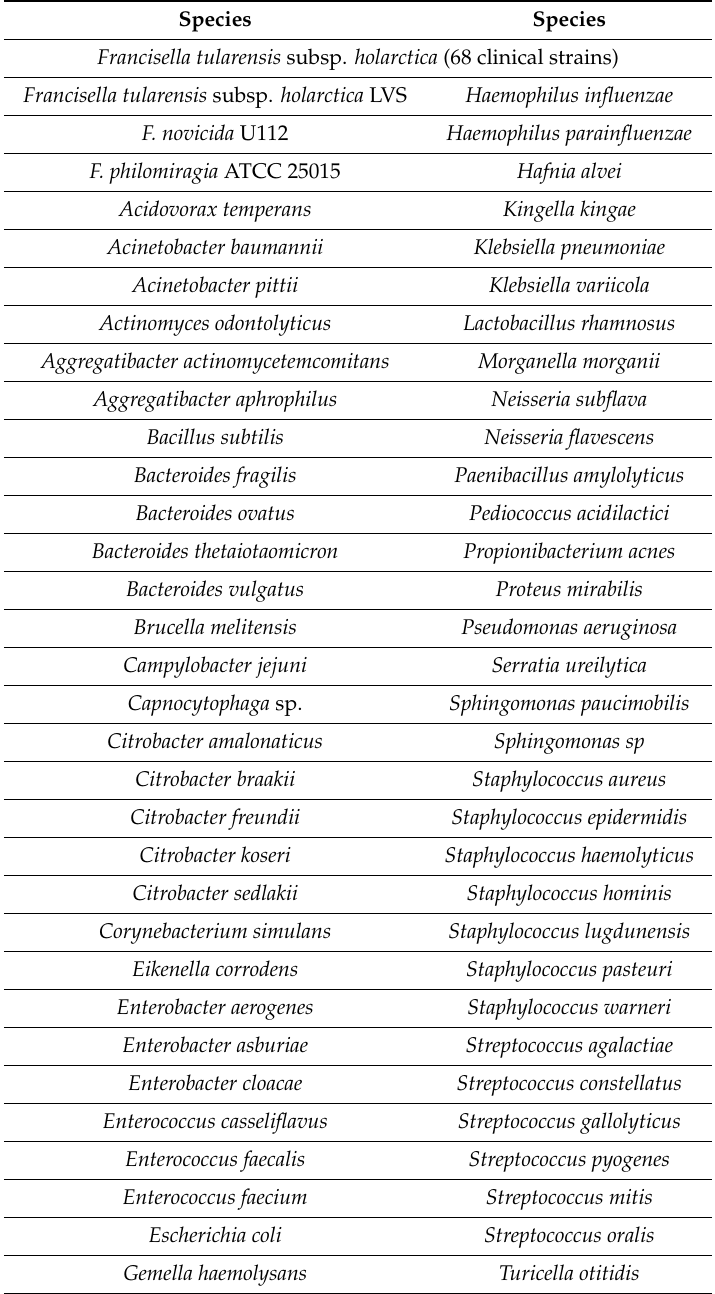
Table 1. Bacterial strains used in this